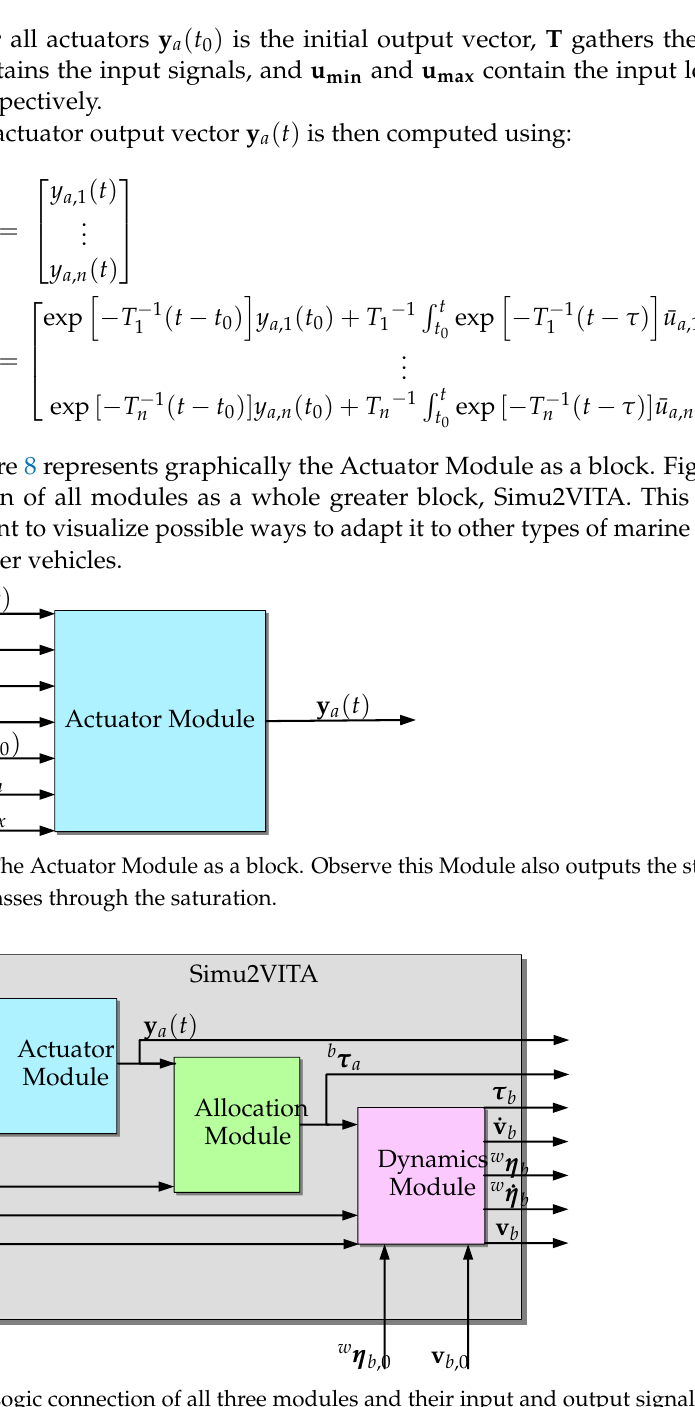
Figure 9. Logic connection of all three modules and their input and output